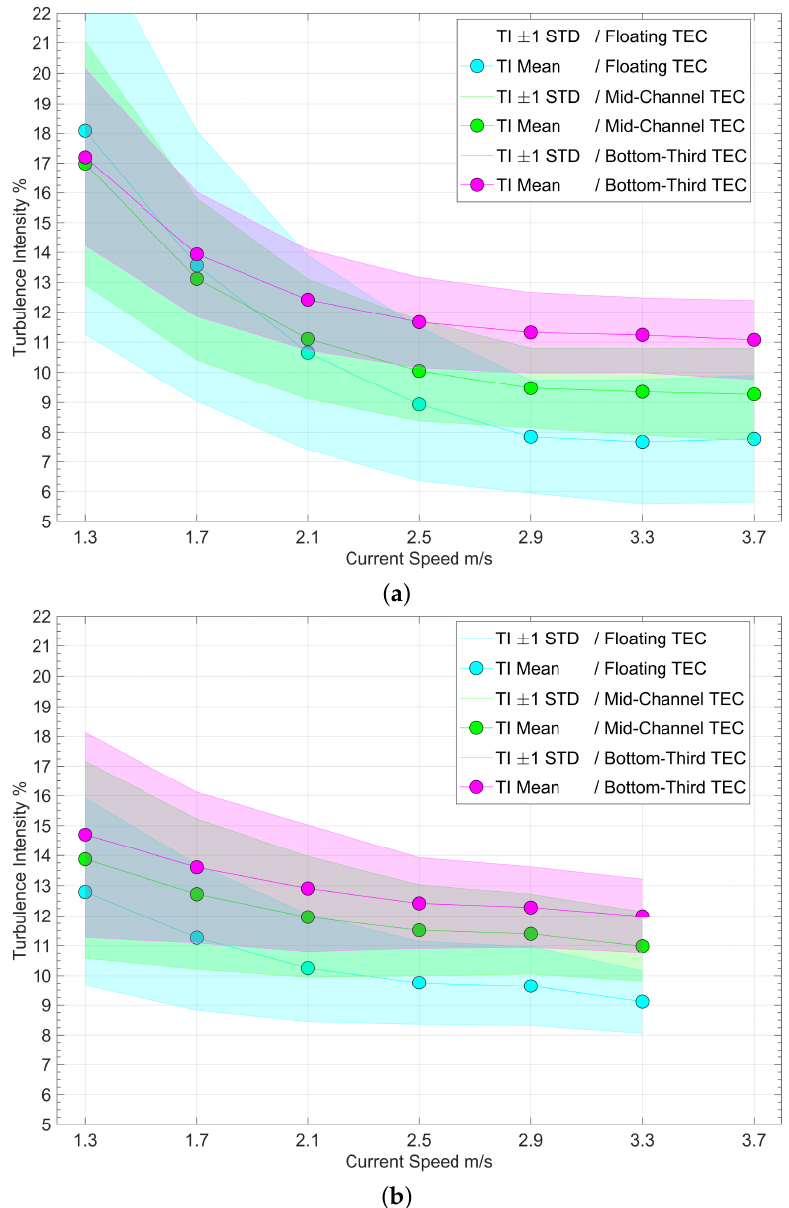
Figure 12. Spatially-averaged TI against current speed for ( a ) ebb and ( b ) flood tides and corresponding levels of variation (shown as ± one standard deviation (STD)) across the specific vertically-sampled region for the three TEC installation types described in Table 3. ( a ) Ebb tide TI variation with speed. ( b ) Flood tide TI variation with